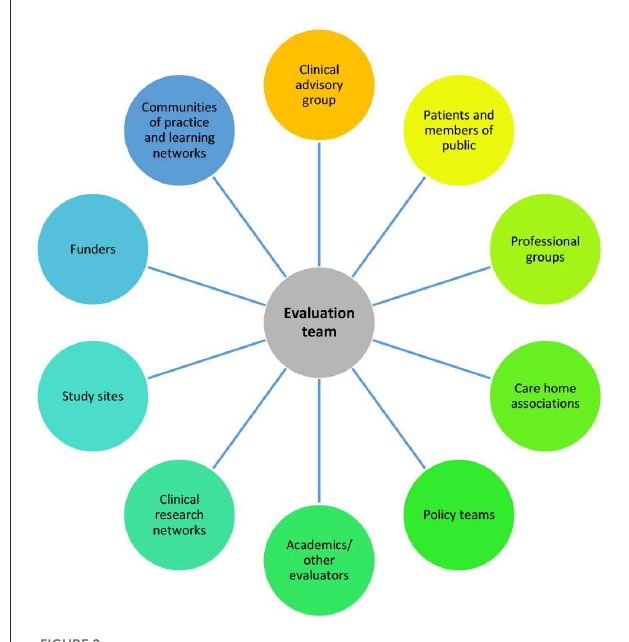
FIGURE2 Summary of external stakeholders who engaged with the